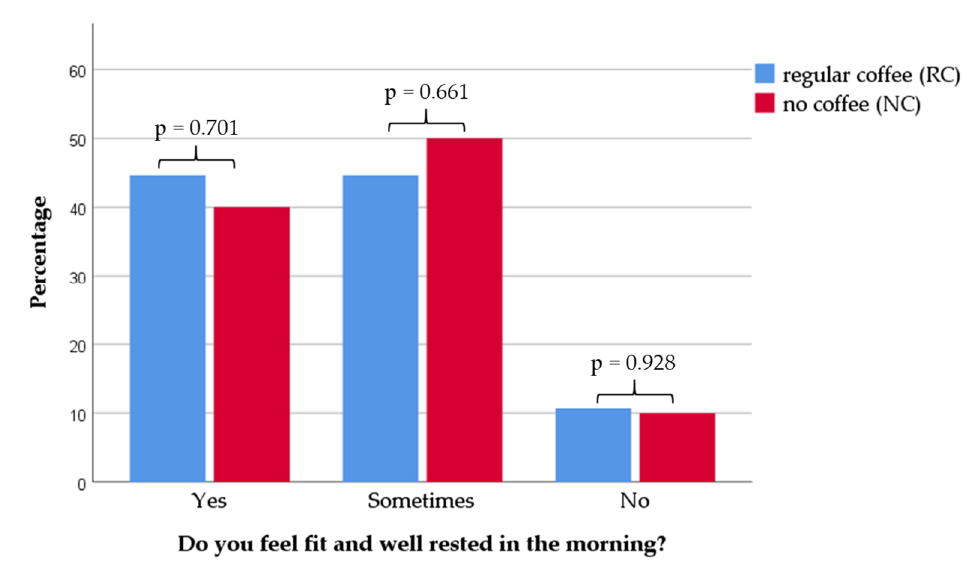
Figure 1. Distribution of sleep quality data in the two groups “fatigue” and “no fatigue”. Patients with fatigue ( n = 46) stated to feel less active and well rested in the morning ( p < 0.001), whereas patients without fatigue ( n = 78) felt more fit in the morning ( p < 0.001; p , statistical significance).